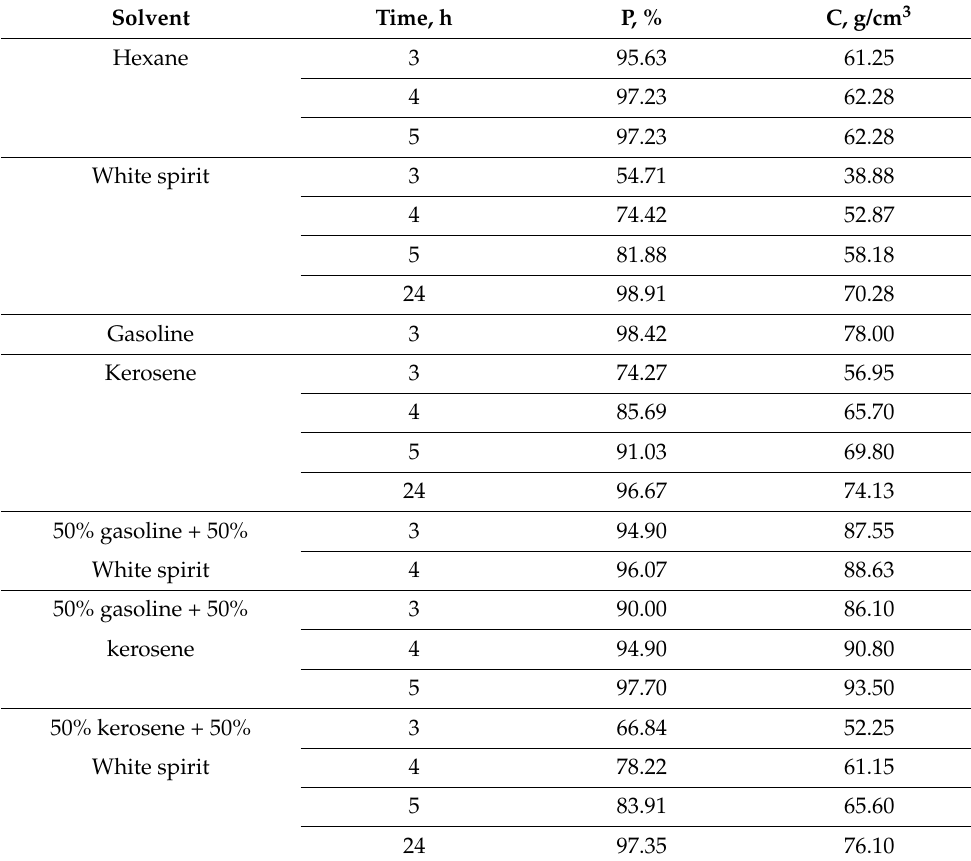
Table 1. Test results for the effectiveness of aliphatic solvents in relation to paraffin deposits of the Zhanaozen